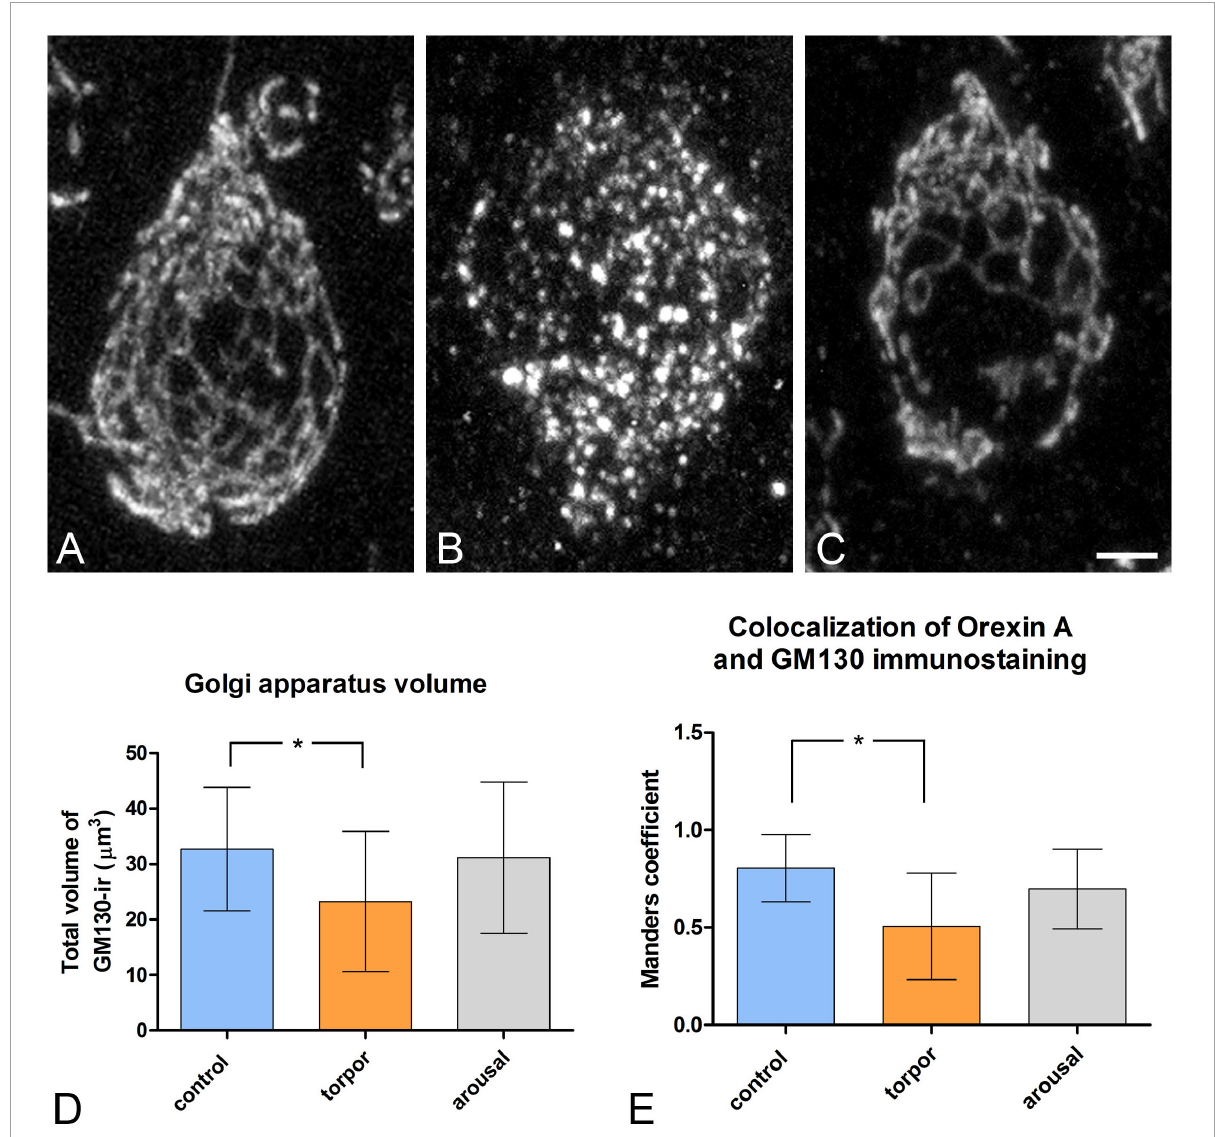
FIGURE10 Distribution of the GA protein GM-130 in LH orexinergic neurons of Syrian hamsters in the three phases of hibernation. (A–C) Confocal Z-projected images showing GM-130-immunostaining of orexinergic cells, obtained from OXA/C-Fos/GM130 triple-immunostained sections from hamsters at euthermia (A) , torpor (B) , and arousal (C) . Note the fragmentation of the GA during torpor and its recovery during arousal. Scale bar indicates 3 µ m. Histograms showing mean ± SD values of volume of the GM130-ir GA elements (D) , and of OXA/GM130 Manders colocalization coefficient (E) obtained from cropped confocal image stacks of complete orexinergic neuronal somata from control, arousal, and torpor animals ( n = 20 for each experimental condition). Kruskal-Wallis and Dunn post hoc tests found significant differences in both GA volume and Manders coefficient mean values between control and torpor groups ( p * ≤